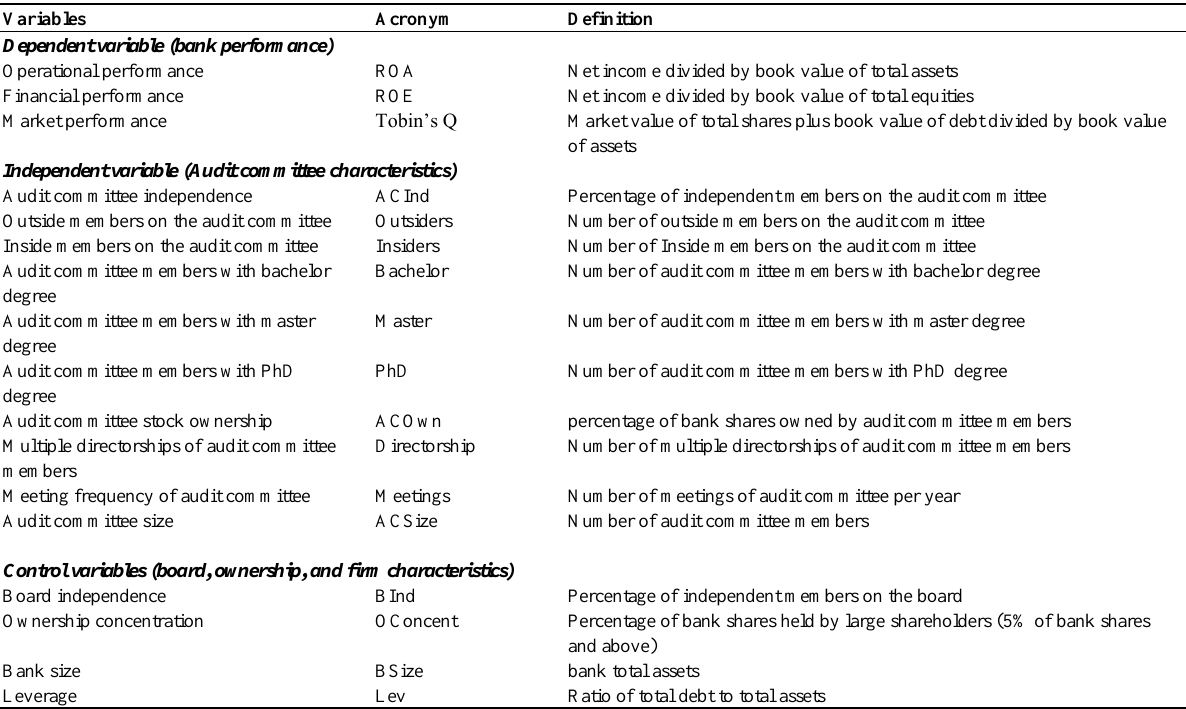
Table 1: Definition of the research